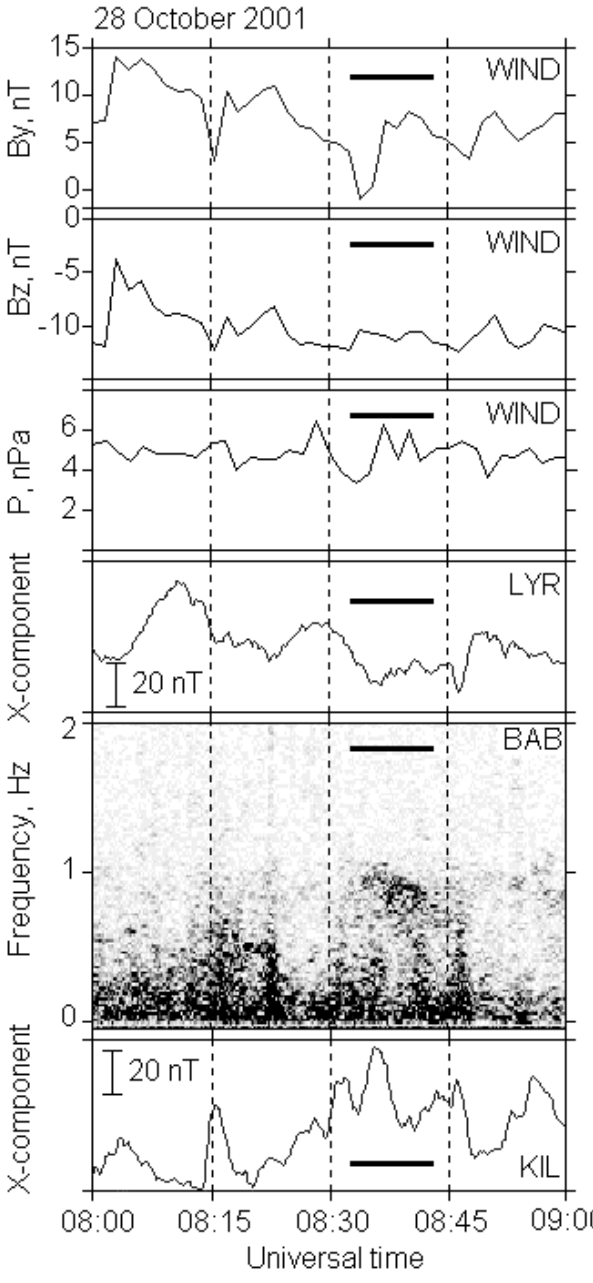
Fig. 5. Pykkvibaer HF radar data showing the line of sight veloc- ity enhancement (negative velocities correspond to plasma motion away from the radar) during the Pc1 event at